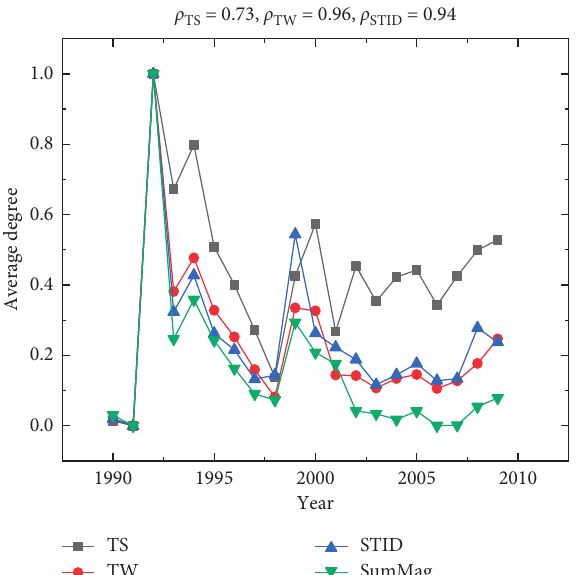
Figure 5: Evolution of the average degree of the networks constructed by TS, TW, and STID. SumMag represents the sum of earthquake magnitudes.